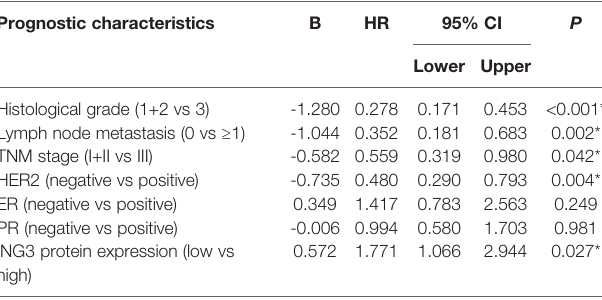
TABLE 2 | Multivariate Cox regression analysis of prognostic variables including classical prognostic factors and nuclear ING3 for 5-year DFS in 211 cases of breast cancer patients.